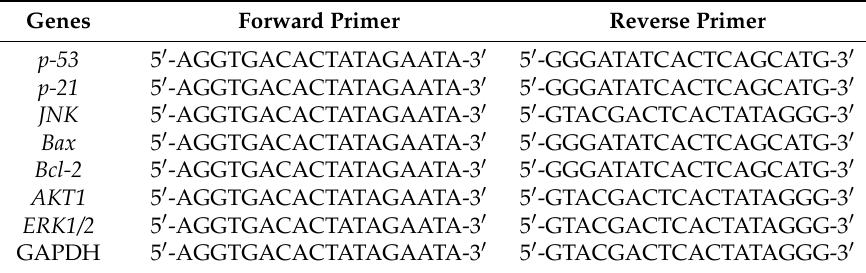
Table 1. Genes used in quantitative real-time-PCR